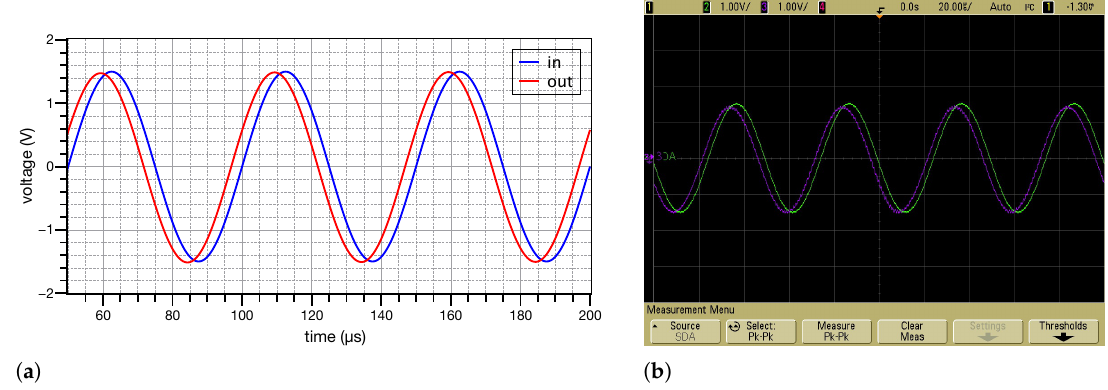
Figure 7. Input and output waveforms of a fractional-order differentiator of order 0.26, realized by the topology in Figure 2a, for a sinusoidal (3V p-p , 20 kHz) stimulus ( a ) theoretical, and ( b ) experimental.